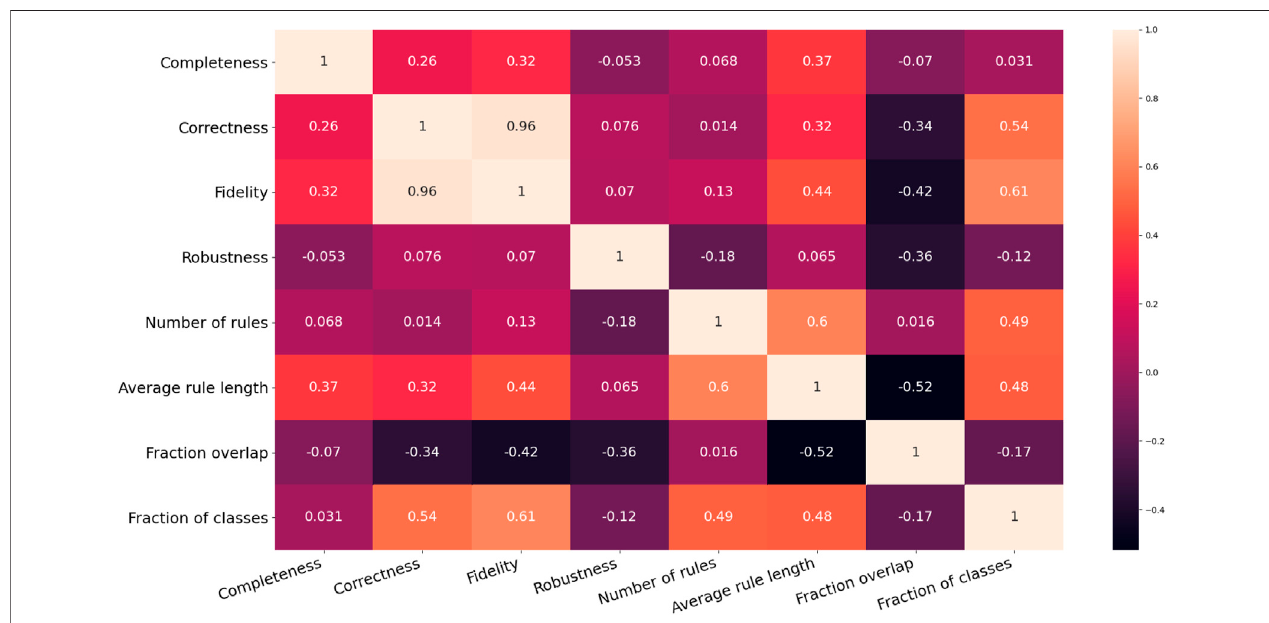
FIGURE 10 | Correlation matrix of the results related to the eight evaluation metrics exploited to assess the degree of explainability ofmachine-generated rulesets.